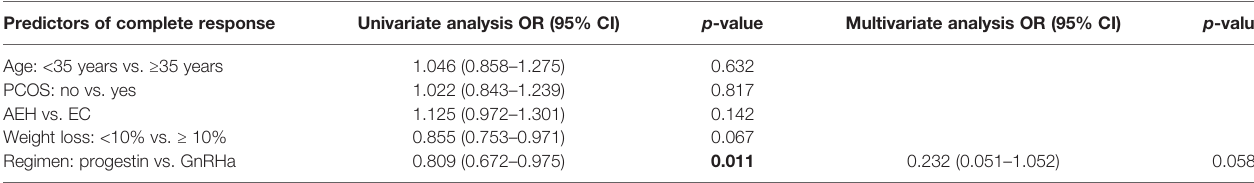
TABLE 2 | Predictors of complete